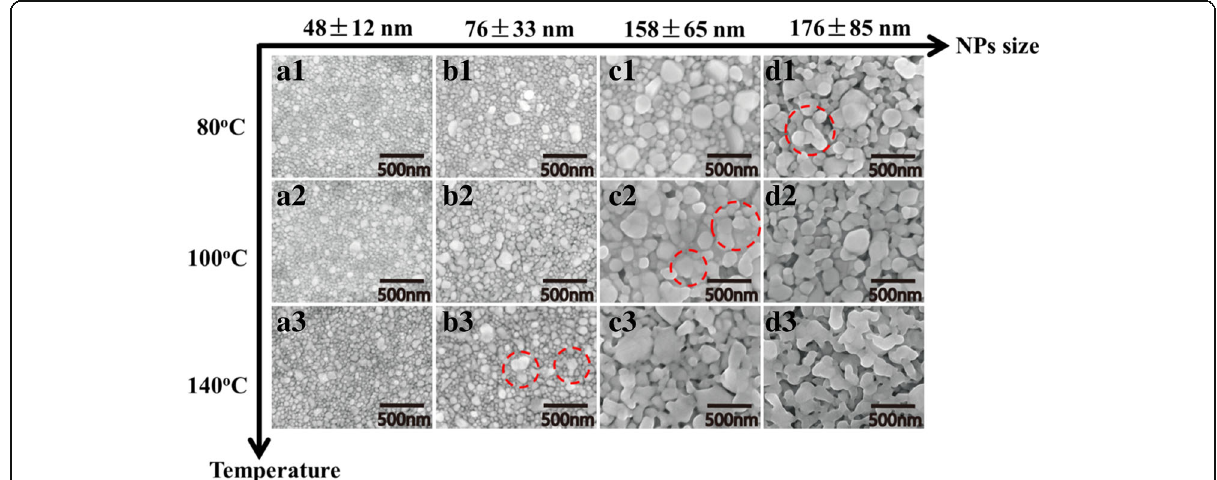
Fig. 6 The morphological evolution of the Ag NP-based films at various temperatures with different sizes; the NP size and heating temperature are marked in the coordinate